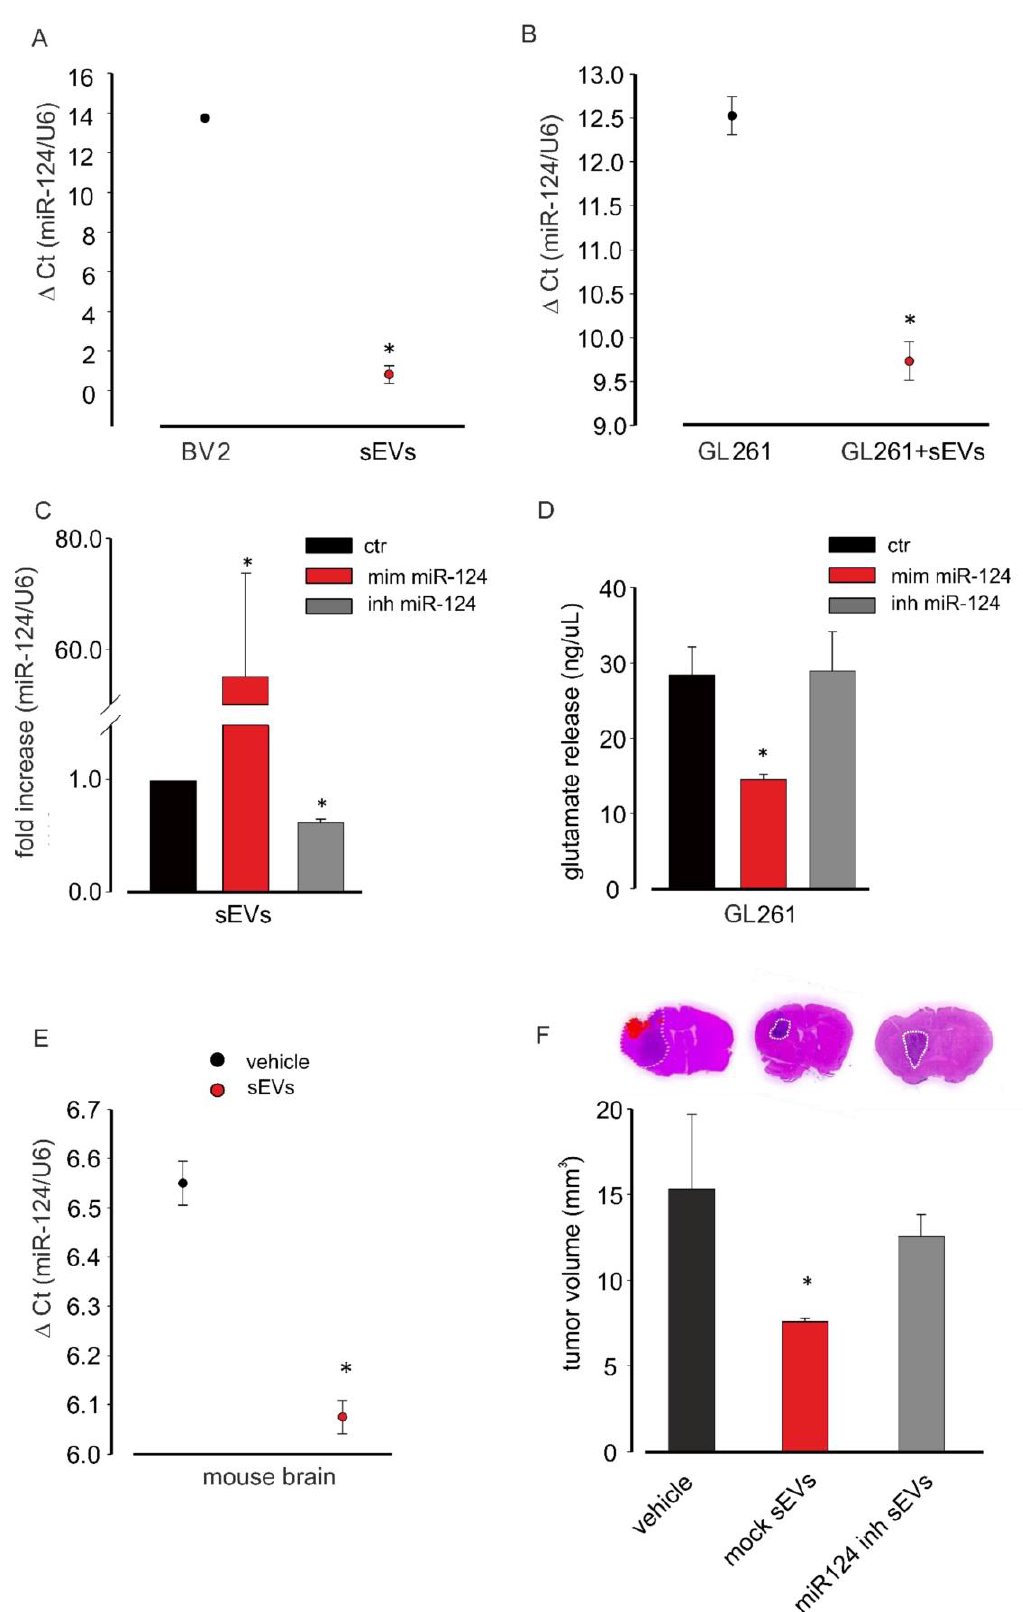
Figure 5. miR-124 analysis in microglia-derived sEVs. ( A ) miR-124 expression levels in BV2 cells and in BV2-derived sEVs evaluated by qRT-PCR analysis. Data are expressed as the mean ± SE of ΔCt, normalized on u6 (used as a housekeeping gene); N = 3; each experiment was performed in duplicate; * p < 0.05; by using Student’s t -test. ( B ) miR-124 expression in